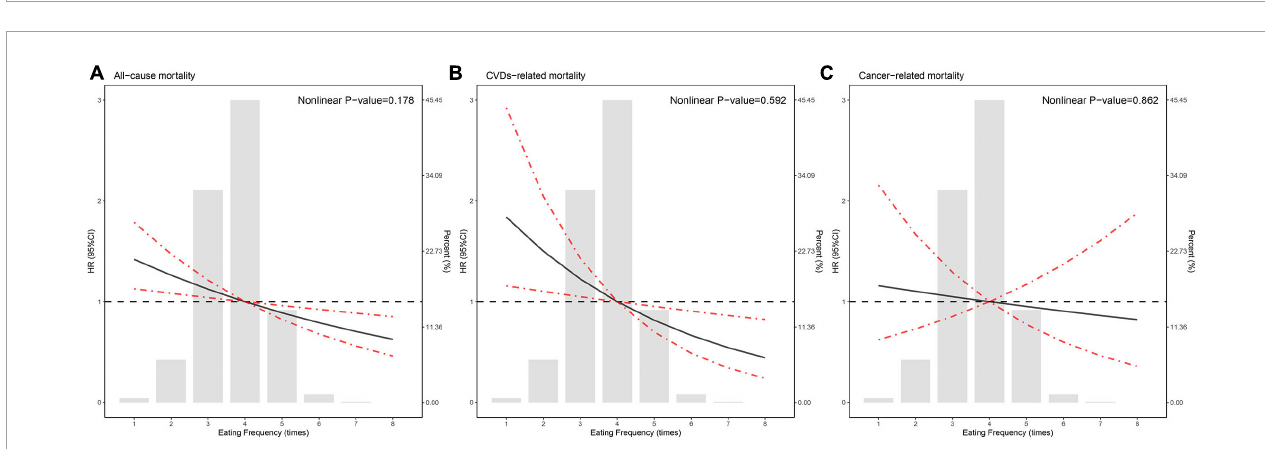
FIGURE2 Hazard ratios for (A) all-cause mortality, (B) cardiovascular disease (CVD)-related mortality, and (C) cancer-related mortality according to eating frequency and the histogram of the probability distribution is presented in the background. Hazard ratios were calculated by Cox models after adjusting for age, sex, race/ethnicity, Body mass index (BMI), education level, family income-poverty ratio, alcohol consumption, smoking status, ideal physical activity, healthy eating index (HEI) score, daily calorie intake, breakfast skipping, diet record days, duration of diabetes, diabetes medication use, self-reported hypertension, hypercholesterolemia, and CVD, self-reported hypertension, hypercholesterolemia medication use, HbA1c, HOMA2_IR, systolic blood pressure, diastolic blood pressure, total cholesterol, triglyceride, high-density lipoprotein, low-density lipoprotein, and estimated glomerular filtration rate